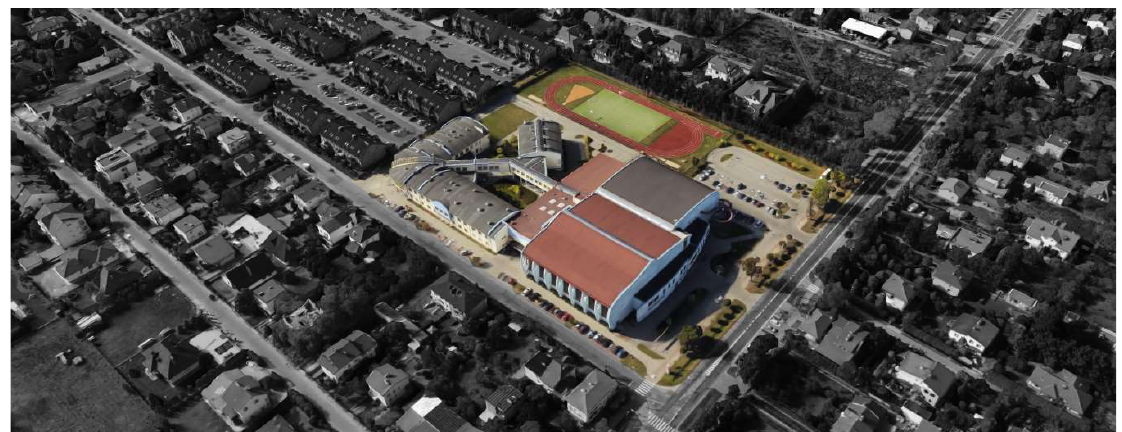
Figure 12. Three-dimensional view of the Integrated Didactic and Sports Center in Łomianki based on google.maps [30].